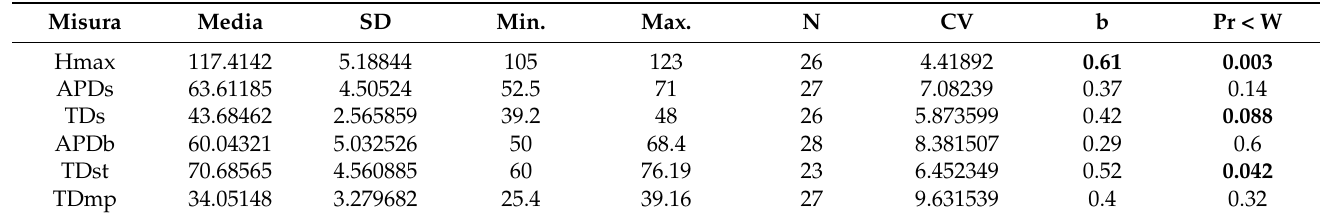
Table 4. Sex-combined statistics for calcaneum